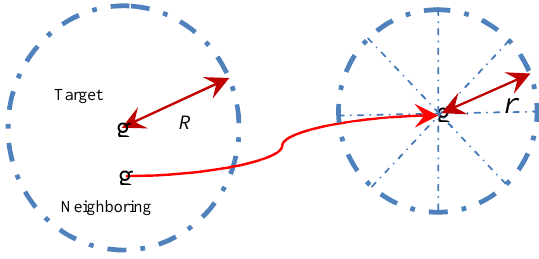
Figure 3. Local Best Matching Point